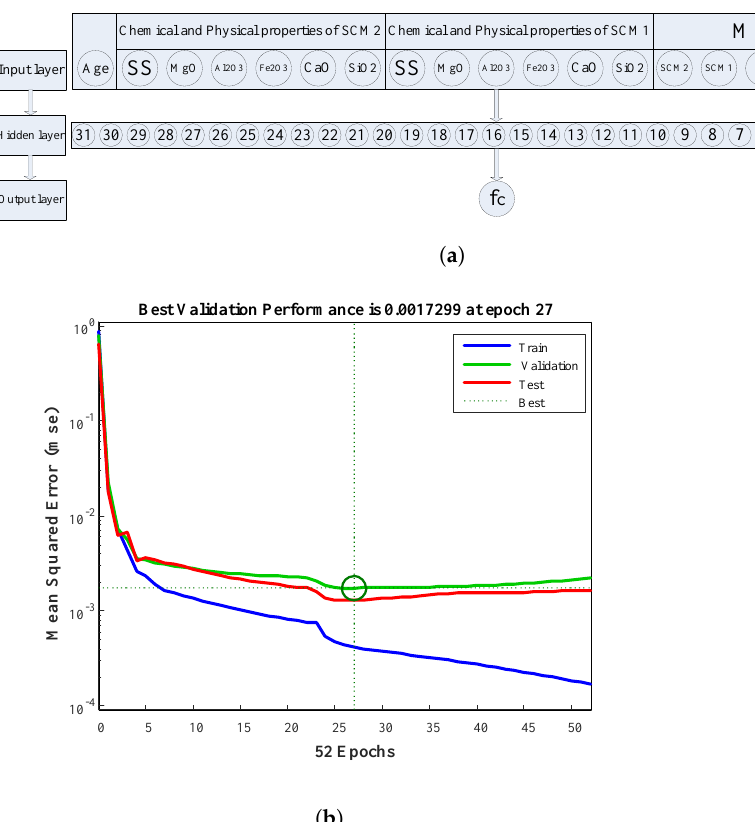
Figure 4. ( a ) The optimal configuration of the MLP network, ( b ) The performance of the proposed MLP